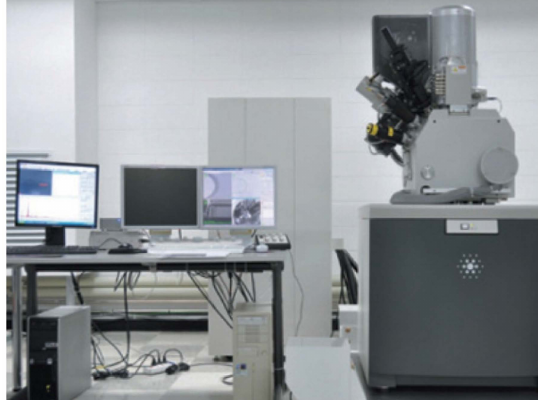
Figure 2. Photograph of focused ion beam system (FEI, NOVA600